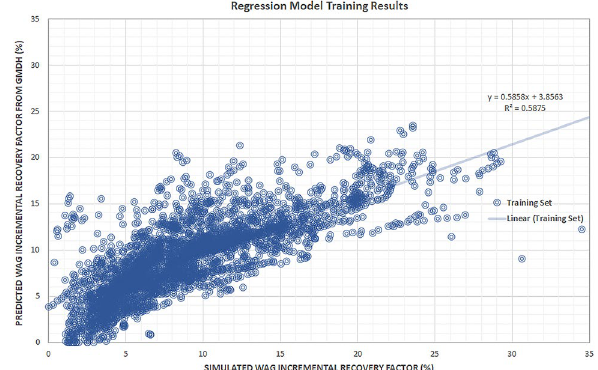
Fig. 12 WAG incremental recovery factor distribution